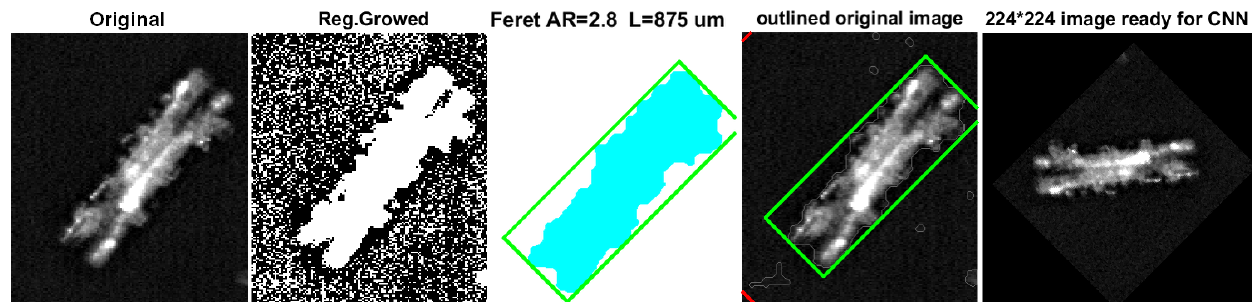
Figure 12. The original image (in this case, a rimed column) is segmented using “region growing”. The projected particle area (clear blue) is calculated. The bounding box is determined (green) and the Feret length and width measured. The image is finally rotated to have the mayor axis horizontal, re-scaled, and resized to the CNN input